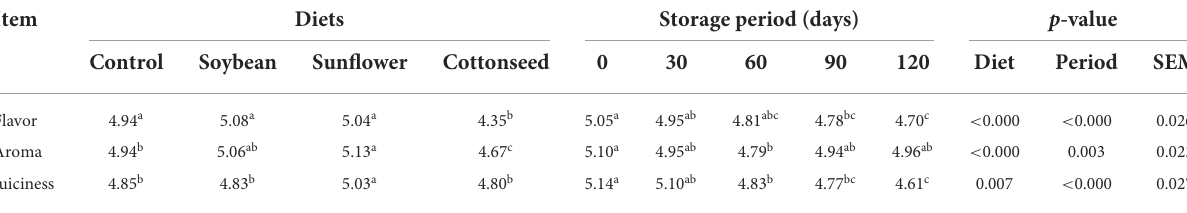
TABLE 7 Sensory characteristics of grilled burgers from steers fed diets with oilseeds and different storage times (0, 30, 60, 90, and 120 days). Item